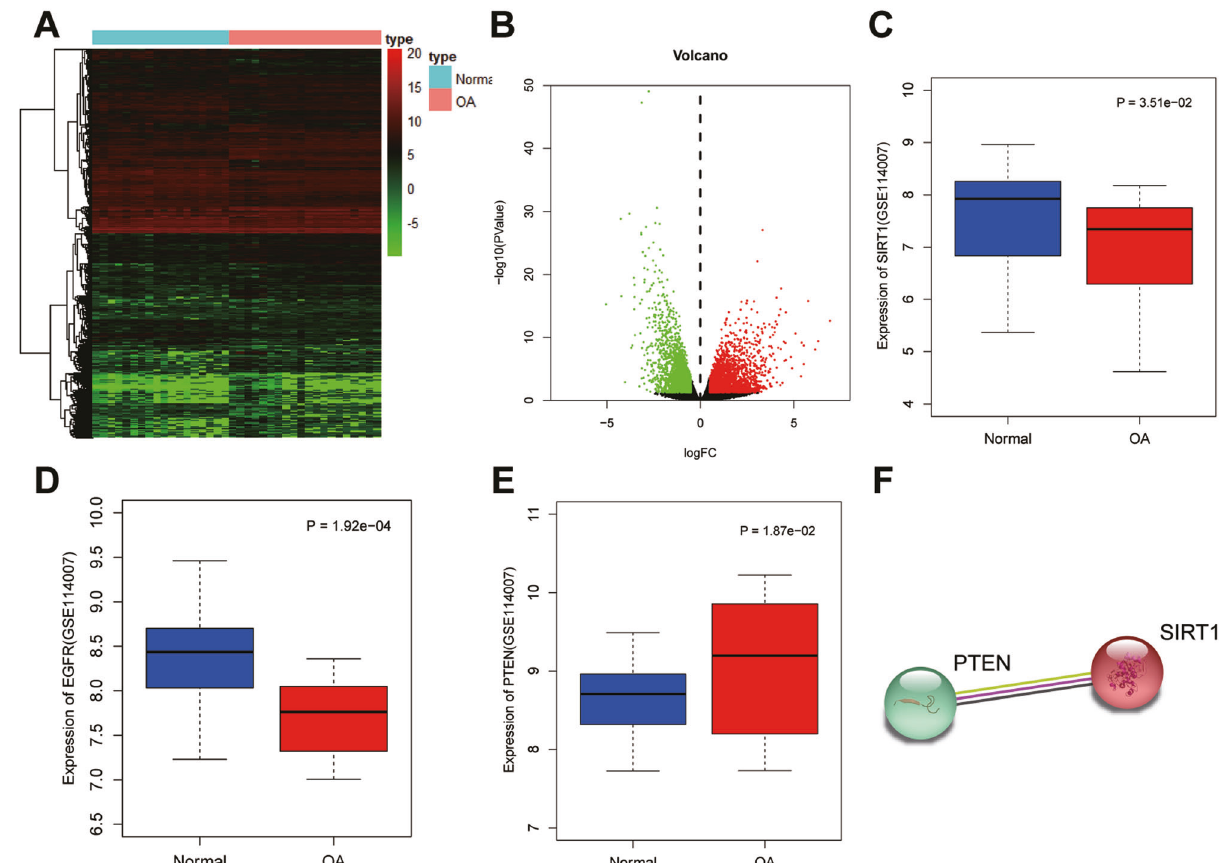
Fig. 1 Bioinformatic identi fi cation of SIRT1-based mechanism in OA. A Heat map of differential gene expression screened in OA on GSE114007 dataset. X axis indicates the sample name, and the Y axis indicates the gene name. Each grid in the fi gure represents the expression of each gene in the corresponding sample. B Volcano map of differential gene expression screened in OA on GSE114007. X axis indicates the negative logarithm of p value (The green dots indicate low expression genes in OA; red dots indicate high expression genes in OA, while black dots indicate no signi fi cant difference genes). C Expression of SIRT1 in OA ( n = 20) and normal ( n = 18) samples. D Expression of EGFR gene in OA ( n = 20) and normal ( n = 18) samples. E PTEN expression in OA ( n = 20) and normal ( n = 18) samples. F STRING protein database analysis of protein – protein interactions of SIRT1 and